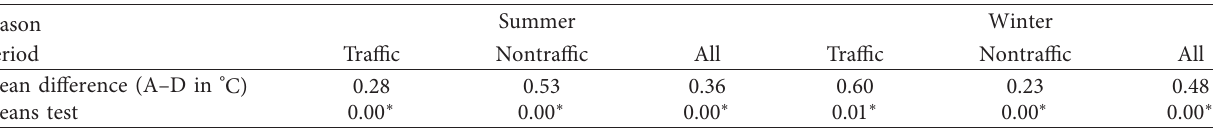
∗ Statistical significance at p � 0 .